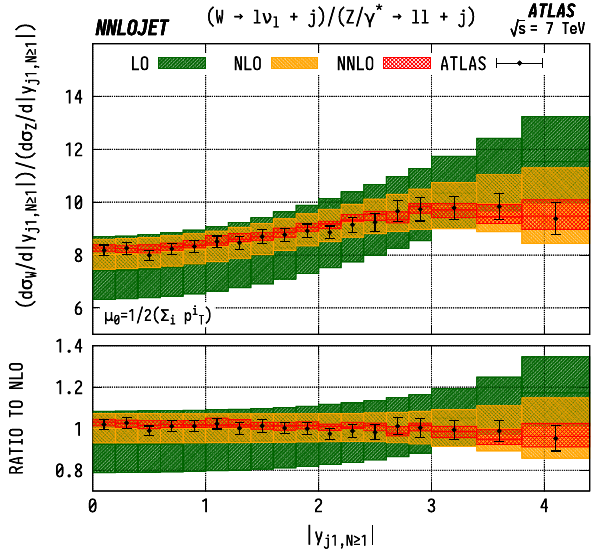
Fig. 24 WJ / ZJ ratio differential in the absolute rapidity | y j | of the leading jet. See Fig. 20 for